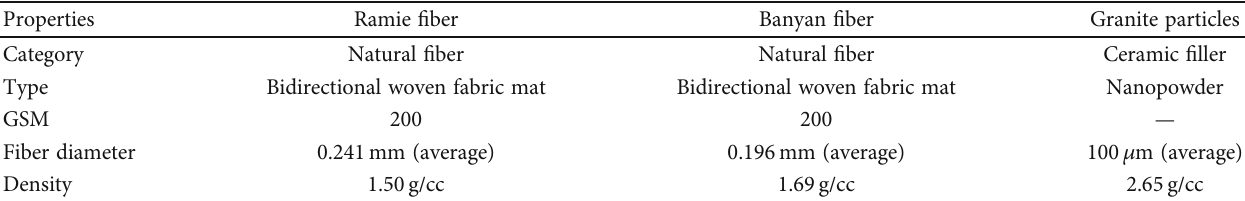
Table 1: Physical properties of ramie and banyan fi bers [16, 17].